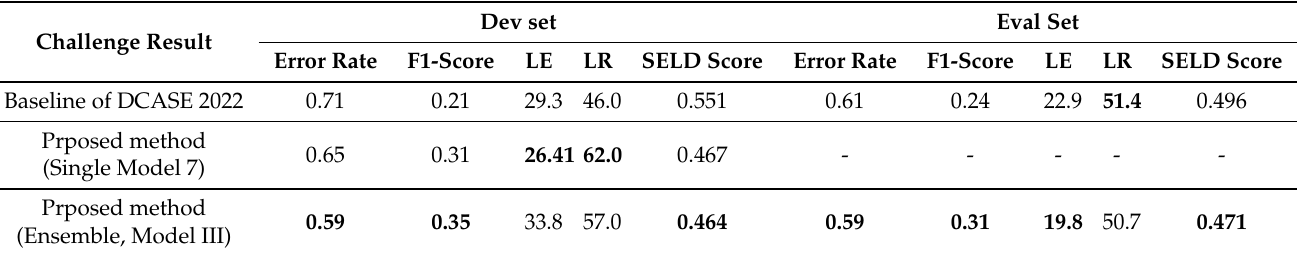
Table 4. Comparison of the performance of the proposed method with that of the baseline model. The values that have the best performance are